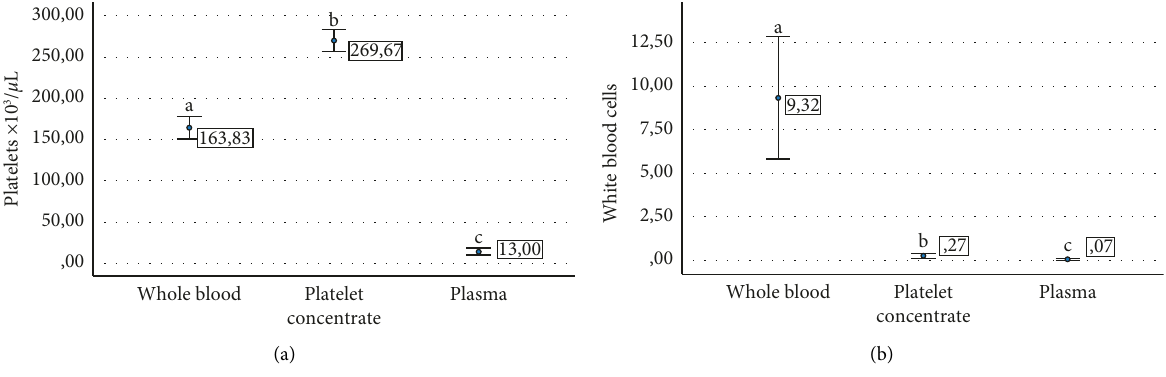
Figure 2: Mean ± sd cell counts in whole blood and hemocomponents. (a) Platelet counts. (b) White blood cell counts. a–c Different lowercase letters denote significant ( P < 0 . 001) differences between whole blood and hemocomponents by the Games–Howell post hoc test.